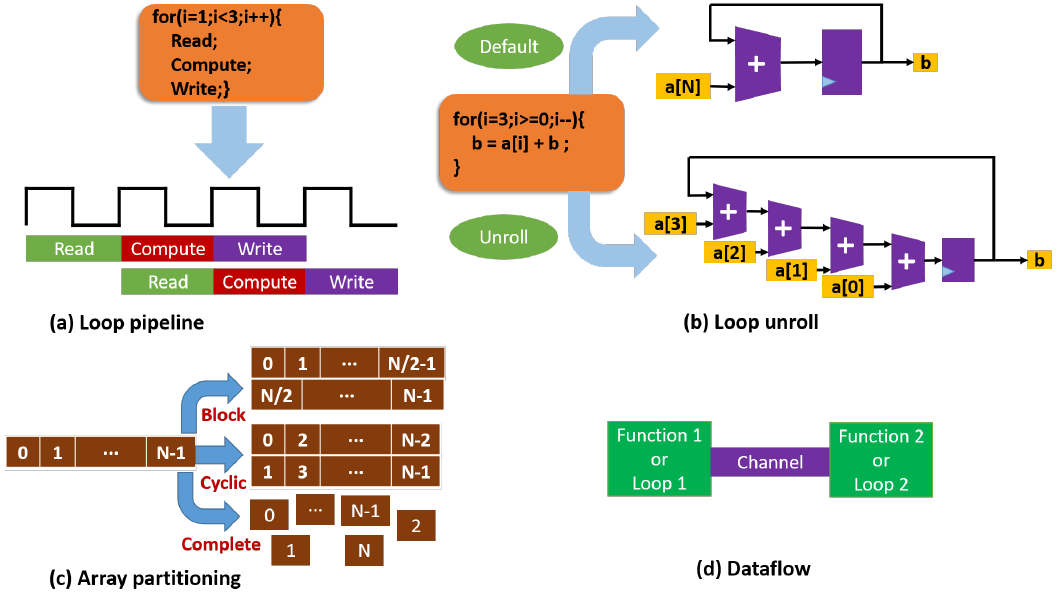
Figure 7. Hardware optimization